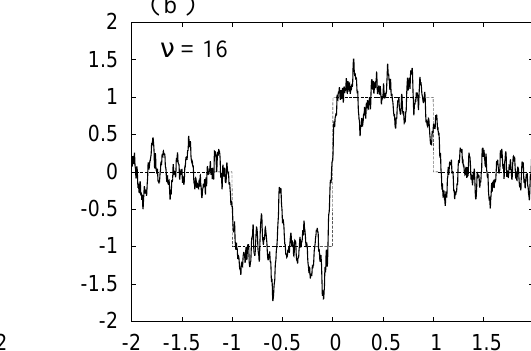
Figure 6. ( a ), ( c ), ( e ): M Mollifier 2. The thinner curves show M